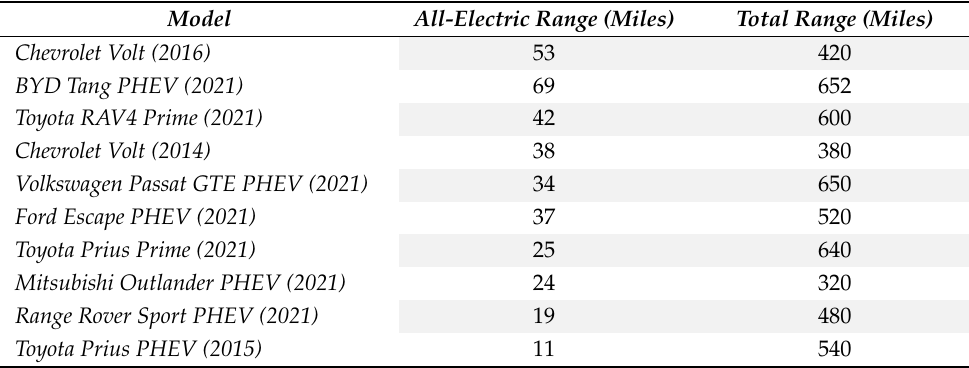
Table 5. The All-Electric and Total Driving Ranges of Selected PHEVs [82]. Model All-Electric Range